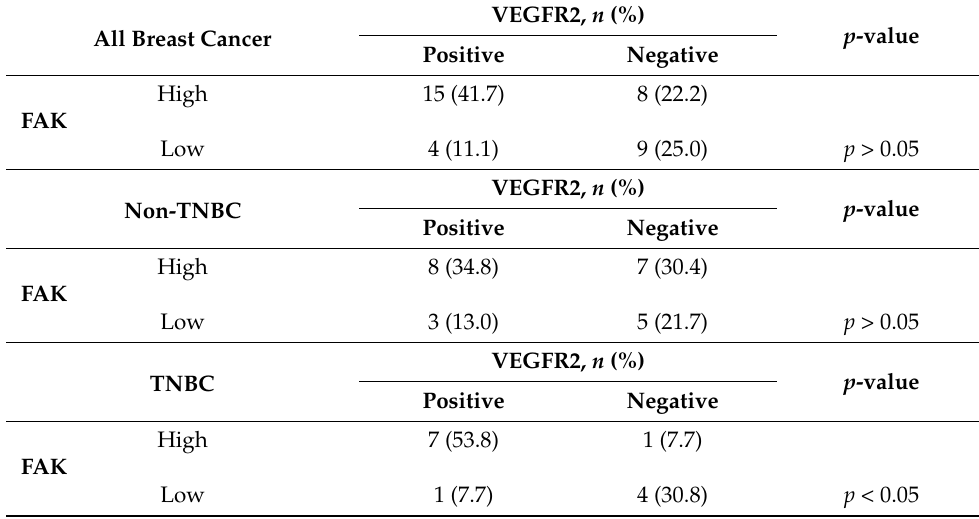
Figure 1. FAK gene expression is positively correlated with VEGFR2 expression in patients with TNBC. Data sets were categorized as “Total breast cancer”, “non-TNBC” (if tumors were positive for either ER, PR, or ERBB2), and “TNBC” (if negative for ER, PR, and ERBB2). These data were obtained from the Oncomine database (https://www.oncomine.com, accessed on 25 July 2021). FAK and VEGFR2 expression were analyzed from ( A ) TCGA, ( B ) Esserman breast, and ( C ) Waddell breast data sets. Table 1. Association of FAK and VEGFR2 expressions in all breast cancer tissues, non-TNBC tissues and TNBC